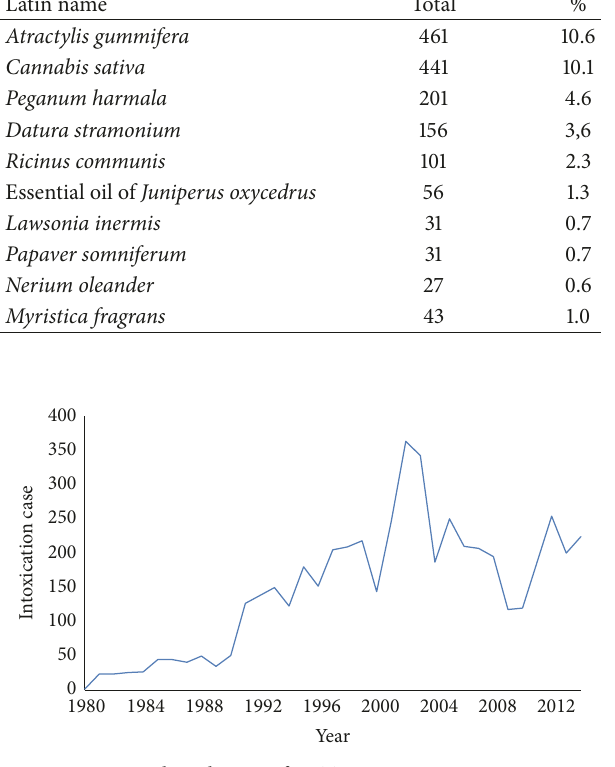
Figure 2: Annual evolution of PPTP intoxication cases, ACPM, 1980–2015 [6,